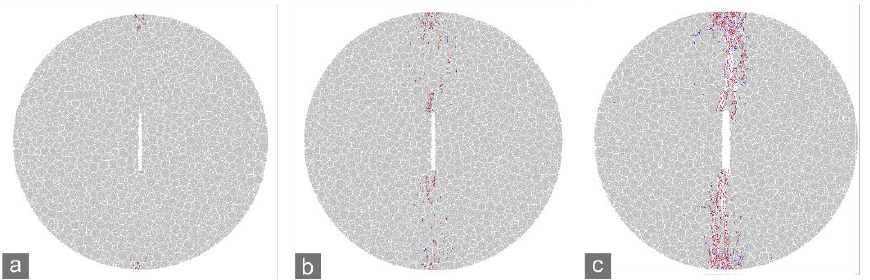
Figure 11. Simulated cracking process of marble J CCNBD specimen. ( a ) Cracking initiation at notched crack tips (~70% P max ); ( b ) reaching P max ; ( c ) specimen rupture.